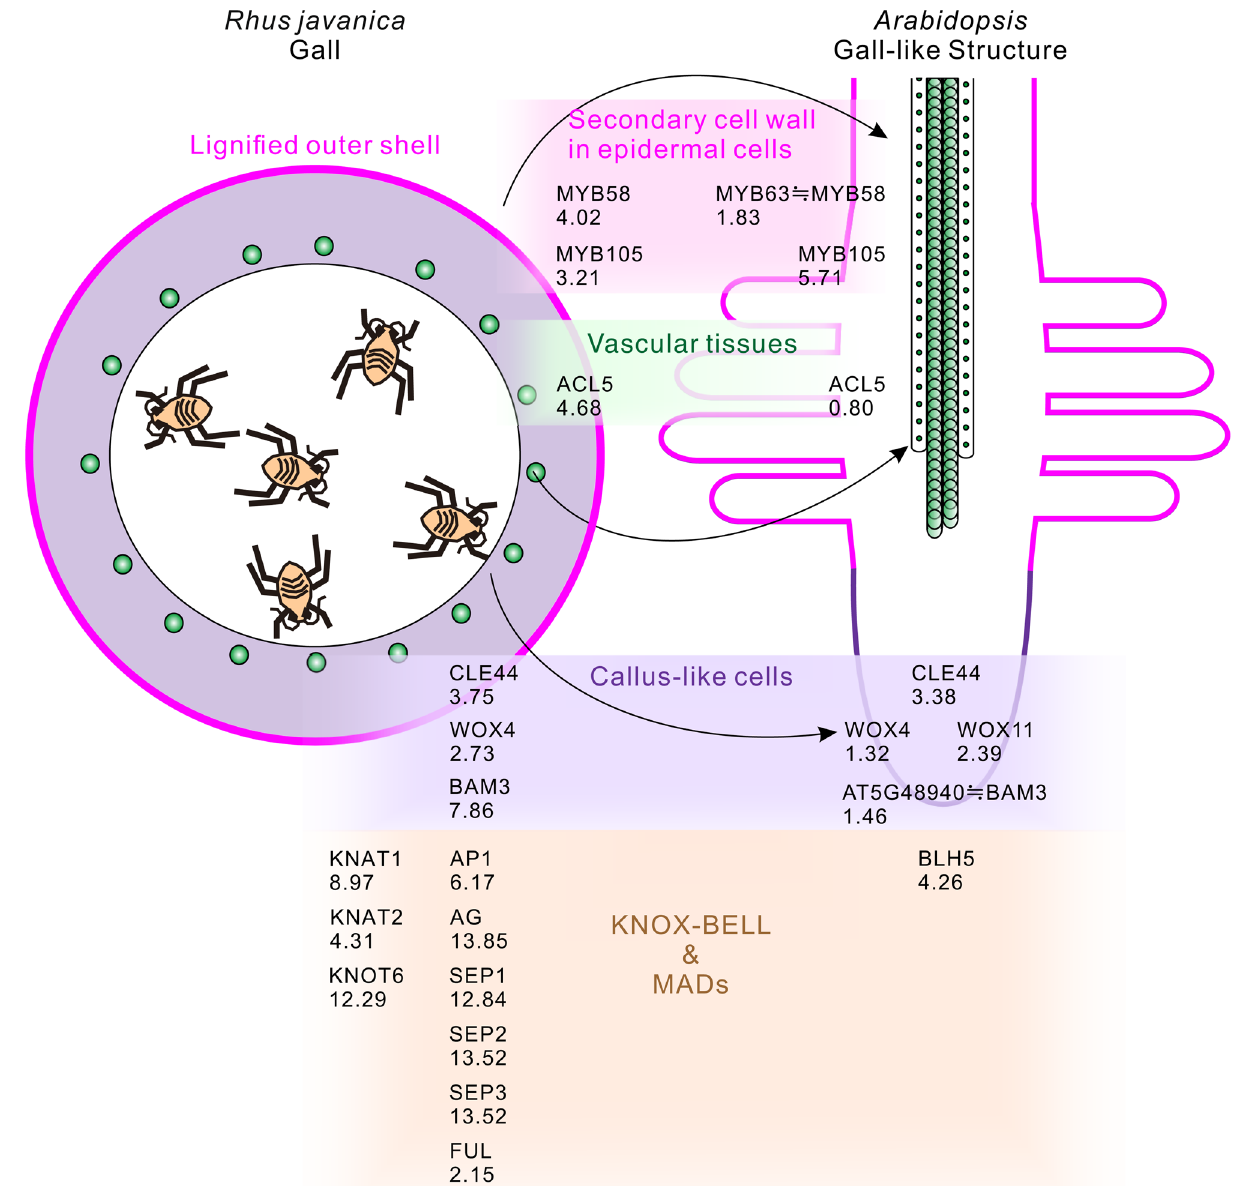
Figure 8. Comparison of the tissue structures and expressed genes of the gall-like structures in Arabidopsis in the root-tip region with Rhus javanica galls. The arrows in the schematic illustration indicate the corresponding tissue structures between R. javanica galls and Arabidopsis gall-like structures. The numbers in the figure represent the log-fold change values of the DEGs compared with each control